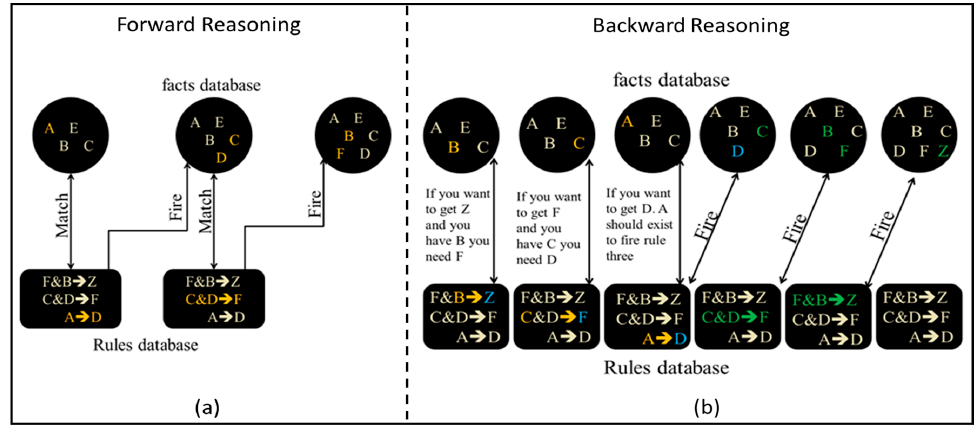
Figure 5. (a) Forward Reasoning—an Example; (b) Backward Reasoning—an Example.